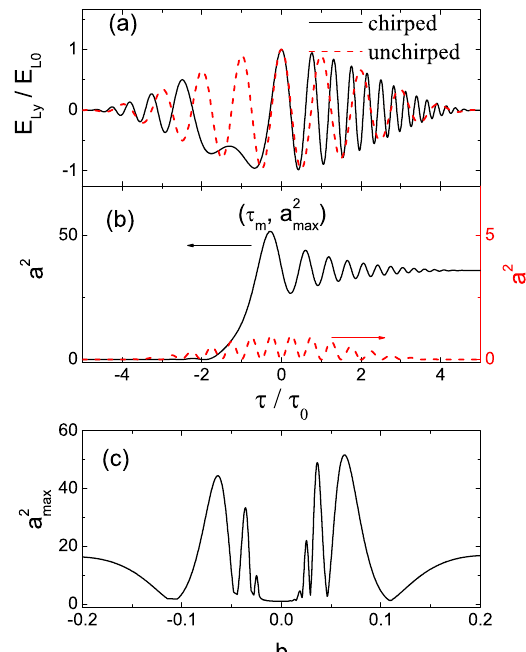
FIG. 1. (a) The normalized electric fields of plane wave pulses as Eq. (1) with (cid:7) 0 ¼ 0 and (cid:6) T ¼ 5 (cid:4) 0 . The chirp parameter for the chirped pulse is b ¼ 0 : 0635 . (b) The corresponding parame- ters a 2 depending on (cid:3) of chirped and unchirped pulses. Here ¼ mc! =e . The solid (black) curves represent a chirped E L 0 0 pulse and the dashed (red) curves represent an unchirped pulse. The maximum value of a 2 in (b) is plotted as a function of chirp parameter b in